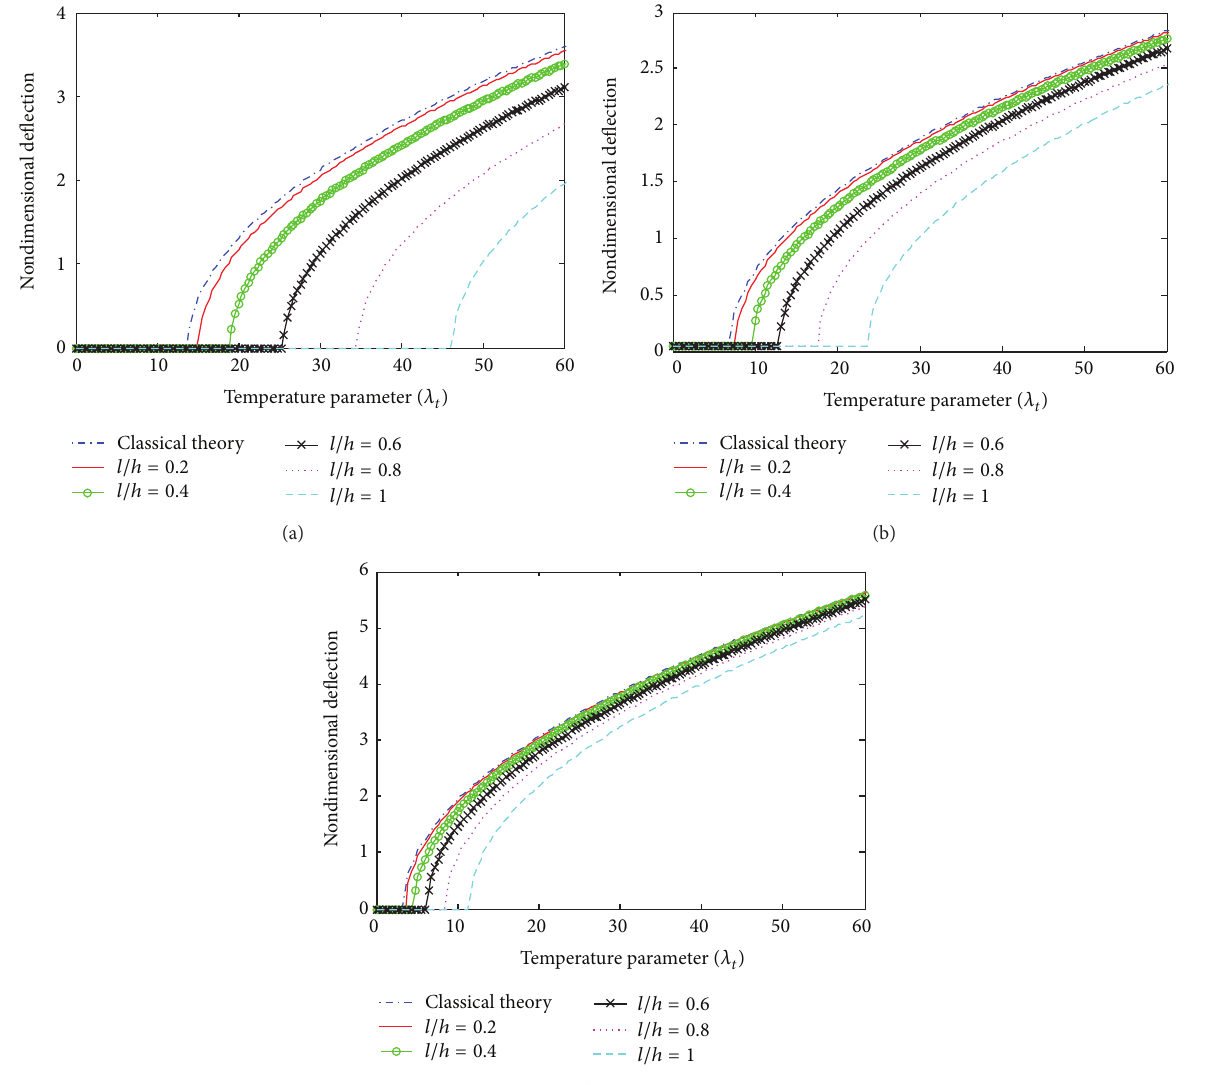
Figure 5: Variation of the nondimensional deflection ( ̂𝑥 = 0.25 ) of (a) clamped-clamped, (b) clamped-simply supported, (c) simply supported-simply supported FG beam with the temperature parameter for different values of 𝑙/ℎ ( 𝑘 = 1 , 𝐿/ℎ = 40 , first buckling